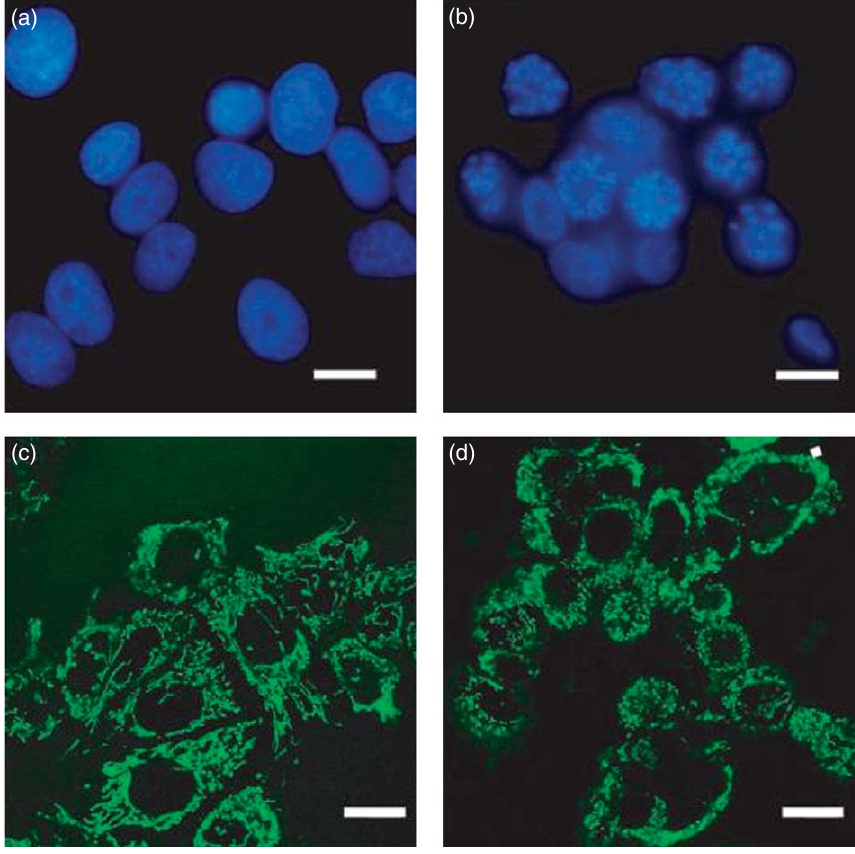
Fig. 14. Representative images from DAPI (a, b) and MitoTracker (c, d) stained control (a, c) and paclitaxel-treated (b, d) MCF-7 cells Scale bars=10 (cid:1) m. Adapted from